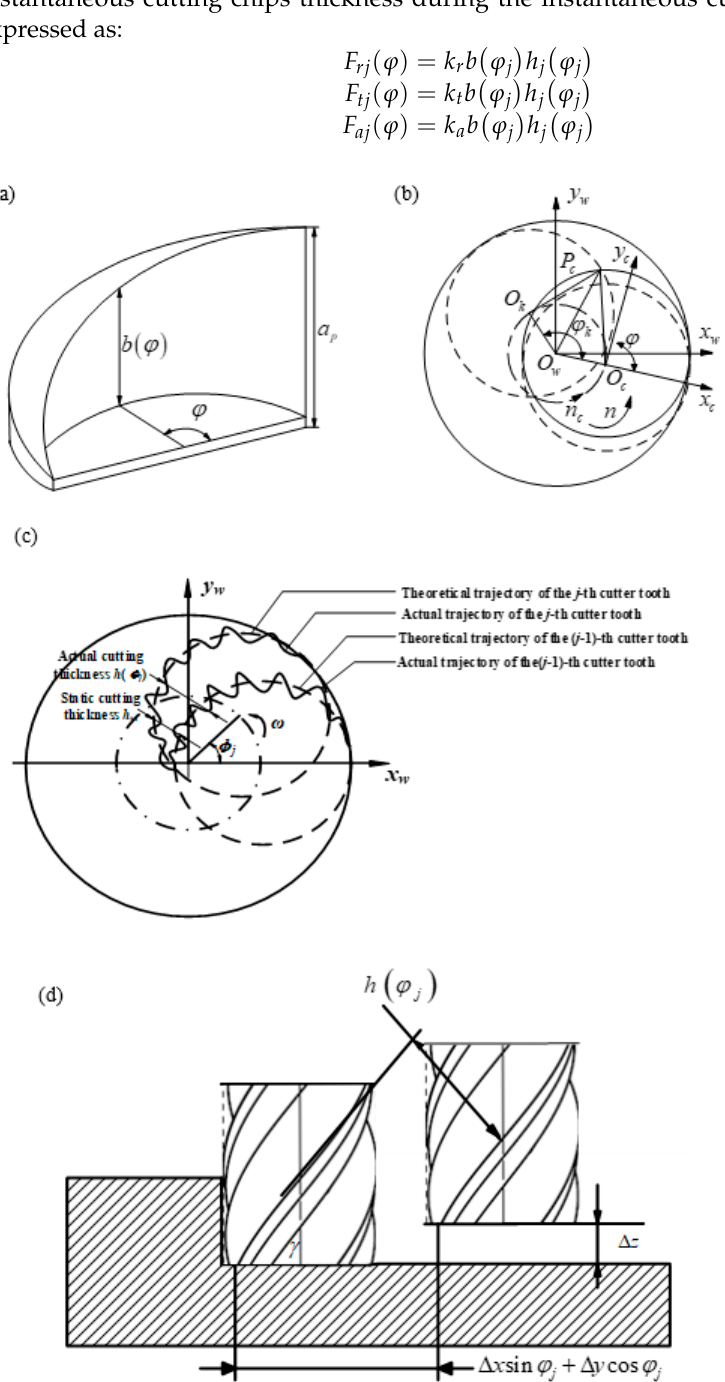
Figure 5. The schematic diagram of cutting thickness of helical milling: ( a ) the chip of helical milling; ( b ) the process of helical milling (top view); ( c ) dynamic cutting thickness of the j -th cutter tooth in the x w direction and y w direction of helical milling; and ( d ) dynamic cutting thickness of the j -th cutter tooth in the z w direction.